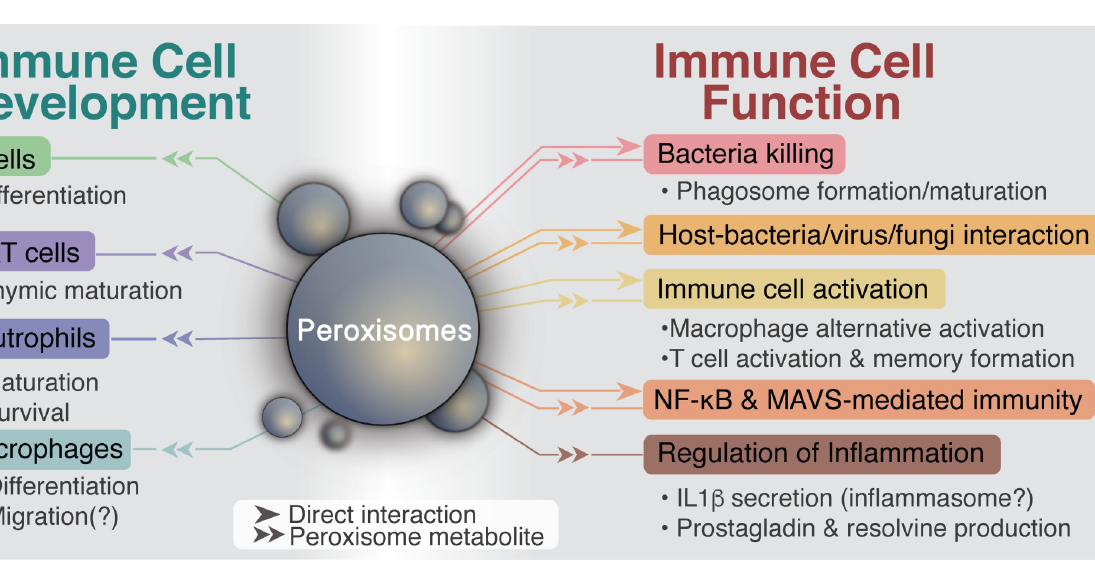
Fig 1. Diagram summarizing the requirements for peroxisomes in modulating host–pathogen